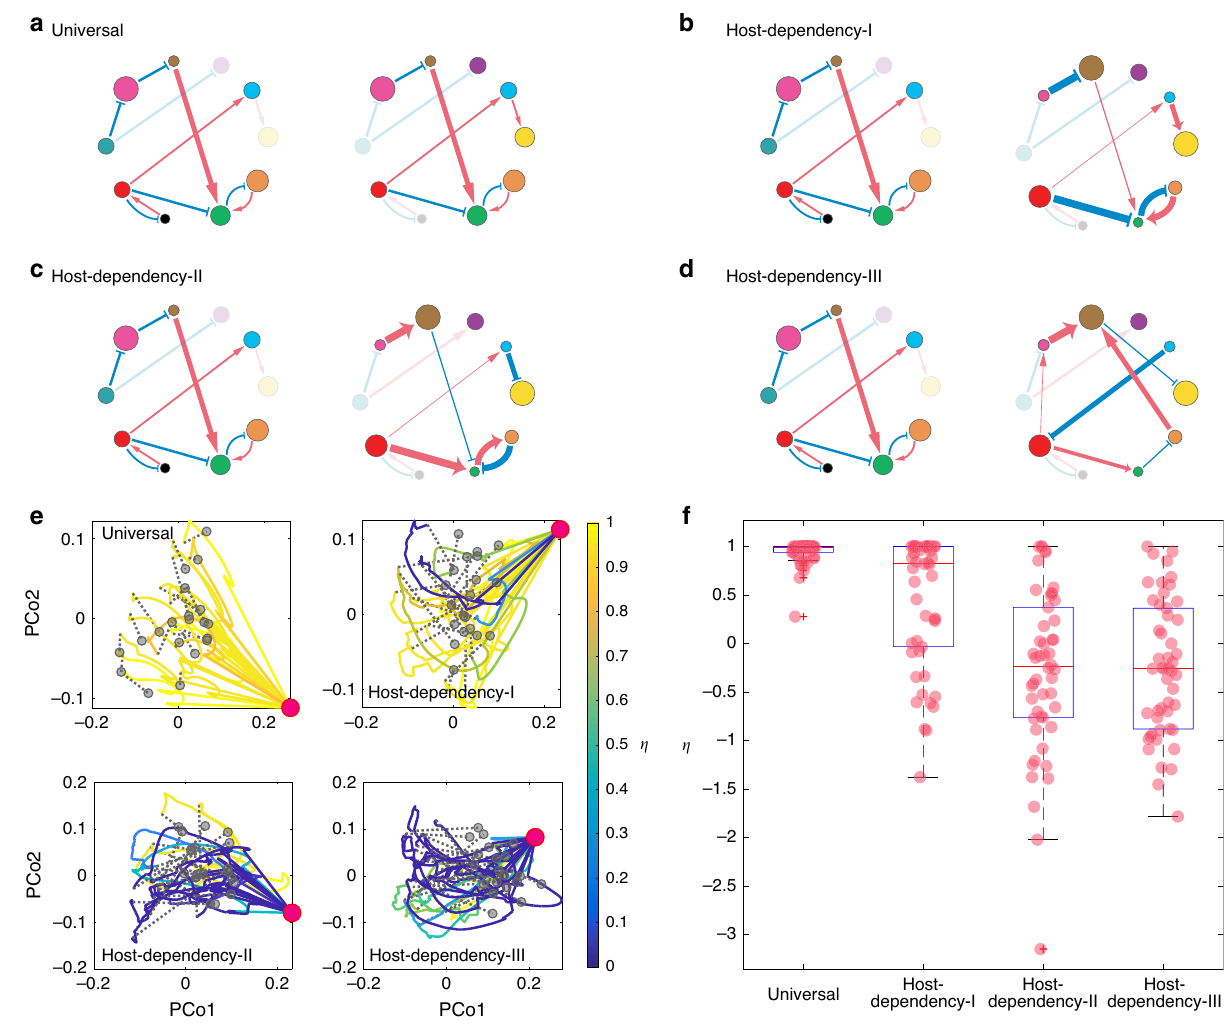
Fig. 3 Impact of host-dependent microbial dynamics on FMT ef fi cacy. a – d Microbial dynamics with four increasing levels of host-dependency, visualized using the ecological network of the donor ’ s (left) and recipient ’ s (right) gut microbiota: a Universal: the two networks are exactly the same. b Host- Dependency-I: they share the same network structure and sign pattern (i.e., interaction types), but have different link weights (i.e., interaction strengths). c Host-Dependency-II: they share the same network structure, but different sign patterns and different link weights. d Host-Dependency-III: they have totally different network structures, different sign patterns, and different link weights. e We performed FMT simulations for each of the four cases (Universal, Host-Dependency-I, Host-Dependency-II, and Host-Dependency-III). In our simulations, we consider a global pool of 100 species, and a particular CDI patient with the diseased state containing only 19 of the 100 species (represented by the red dot in the PCoA plot). We randomly choose 20 healthy donors (represented by the gray dots in the PCoA plot) to perform the FMT for this patient and visualize the time series data of species abundances as trajectories in the PCoA plot, with trajectory color representing the recovery degree evaluated after the recipient ’ s gut microbiota reaches steady state. Note that η does not naturally belong to [0,1]. For the visualization purpose, we forced η > 1 as η = 1 and η < 0 as η = 0. f The recovery degree decreases with increasing level of host-dependency in the microbial dynamics. The model parameters used in the simulations of panels ( e ) and ( f ) are described in Supplementary Note 1. The boxplot is calculated from 50 independent FMT simulations. The central red line indicates the median; the bottom and top edges of the box indicate the 25th and 75th percentiles, respectively. The whiskers extend to the most extreme data points not considered outliers, and the outliers are plotted individually using the cross